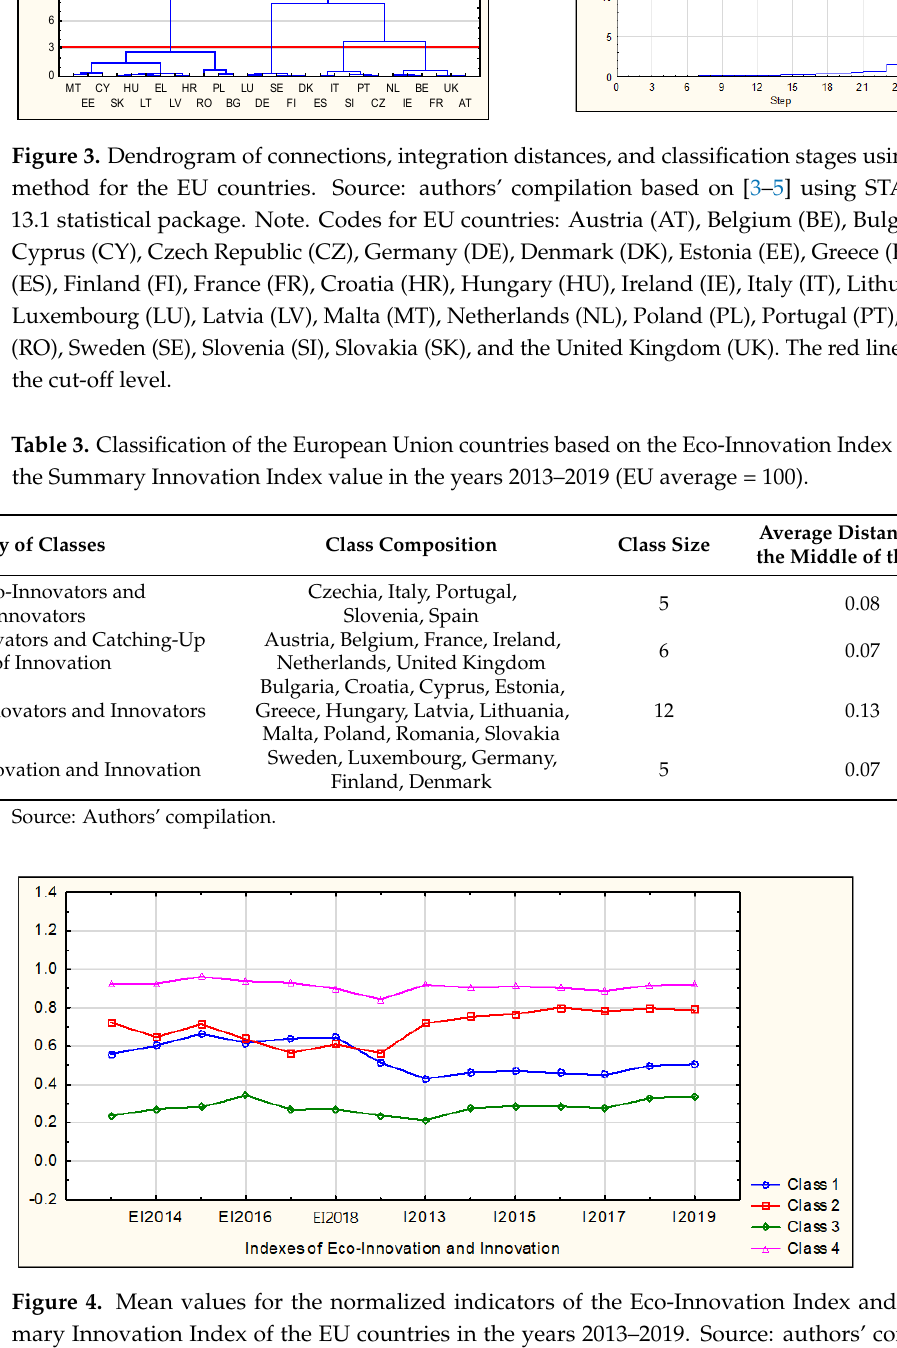
Table 4. Kruskal–Wallis test statistics for four classes of the European Union countries identified using the k-means method regarding the values of the Eco-Innovation Index and Summary Innova- tion Index in 2013–2019. Eco-Innovation Index